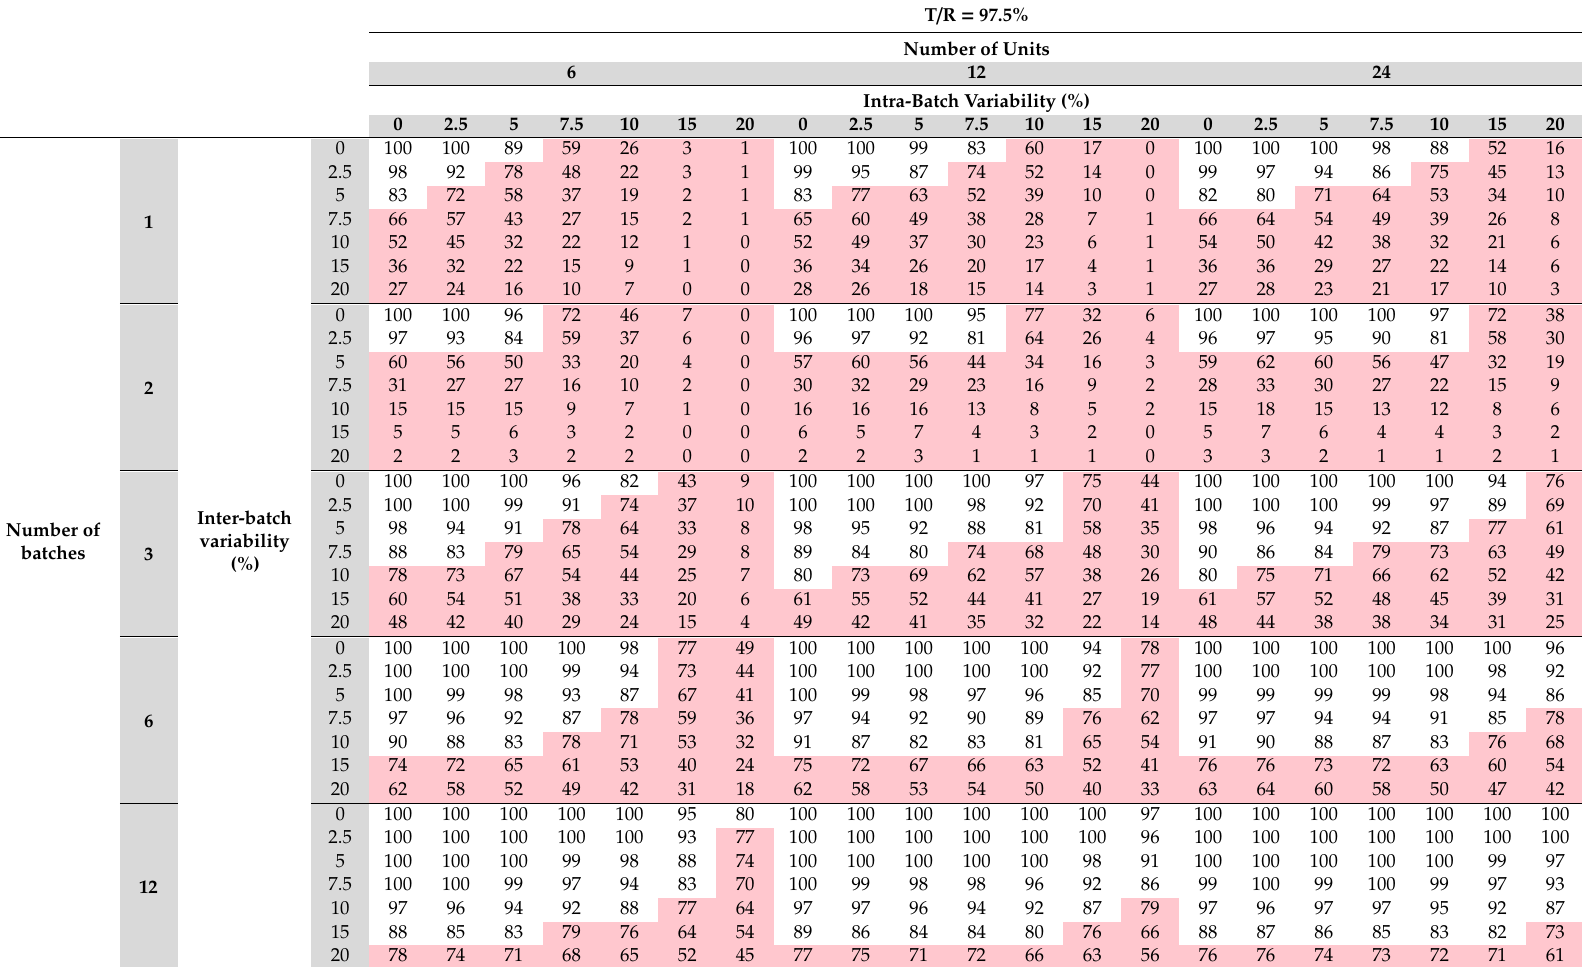
Table 2. Probability of similarity when the population di ff erence between reference and test products is 2.5%. Number of batches and inter-batch variability are depicted in the left margin and number of replicates and intra-batch variability on the top of the table. In red are outlined the scenarios with a probability lower than